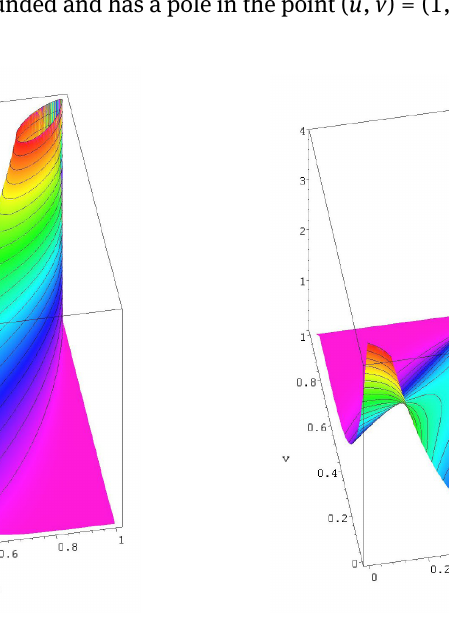
Figure 1: Density of a bivariate negative binomial copula, a = 5 Figure 2: Density of a bivariate Poisson copula, a =